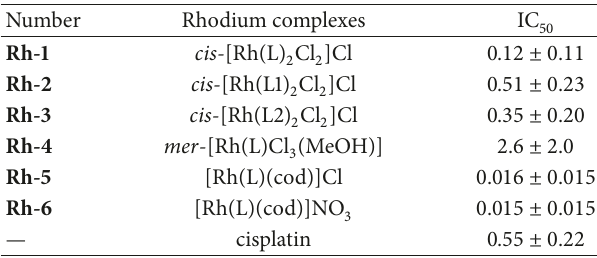
Table 2: IC 50 data ( 𝜇 M) final concentration in the aggregometer cuvette for rhodium PAF inhibitors towards